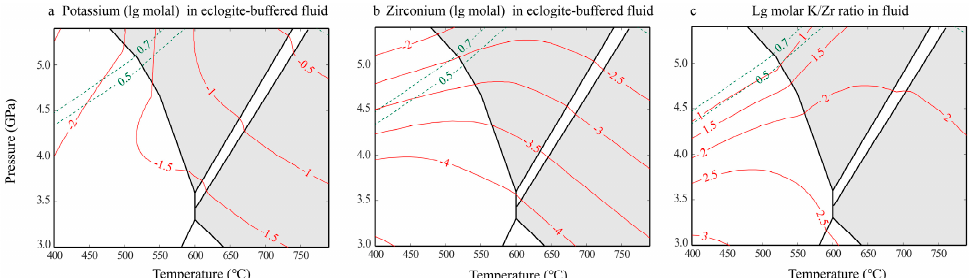
Figure 2. Thermodynamic simulation results of the solubilities of K and Zr in NaCl-absent fluid. ( a ) The solubility of K in the eclogite-buffered fluid shown as logarithm of molality. ( b ) The solubility of Zr as logarithm of molality. ( c ) The solubility ratio of K/Zr in fluid shown as logarithm of molar ratio. Additionally shown are the contours of ionic strengths equal to 0.5 and 0.7 molal (green dashed lines with labels).